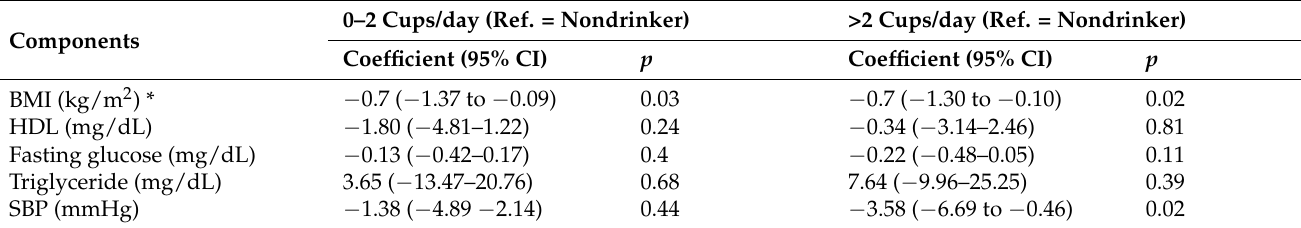
Table 3. Weighted linear regression for the components of the z-score in coffee intake